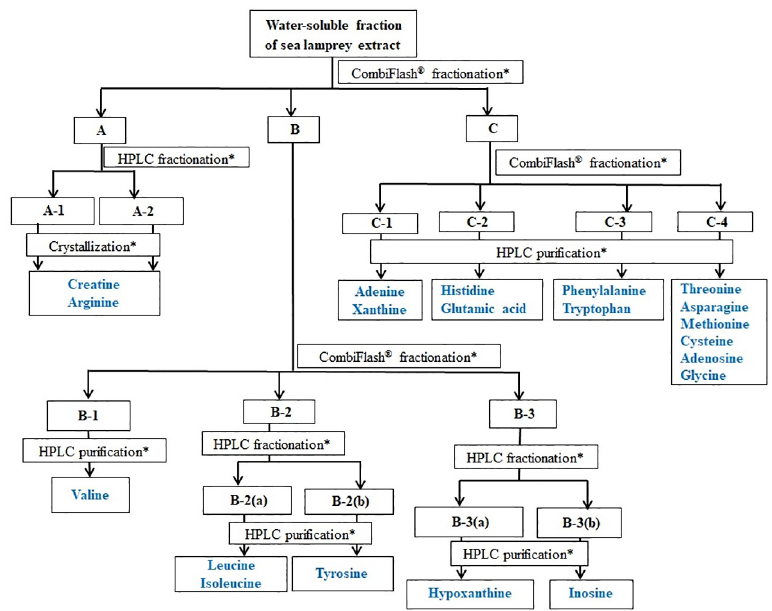
Fig 1. Fractionation and purification of components from the deterrent water-soluble fraction of sea lamprey skin extract. � Details are in the experimental section.